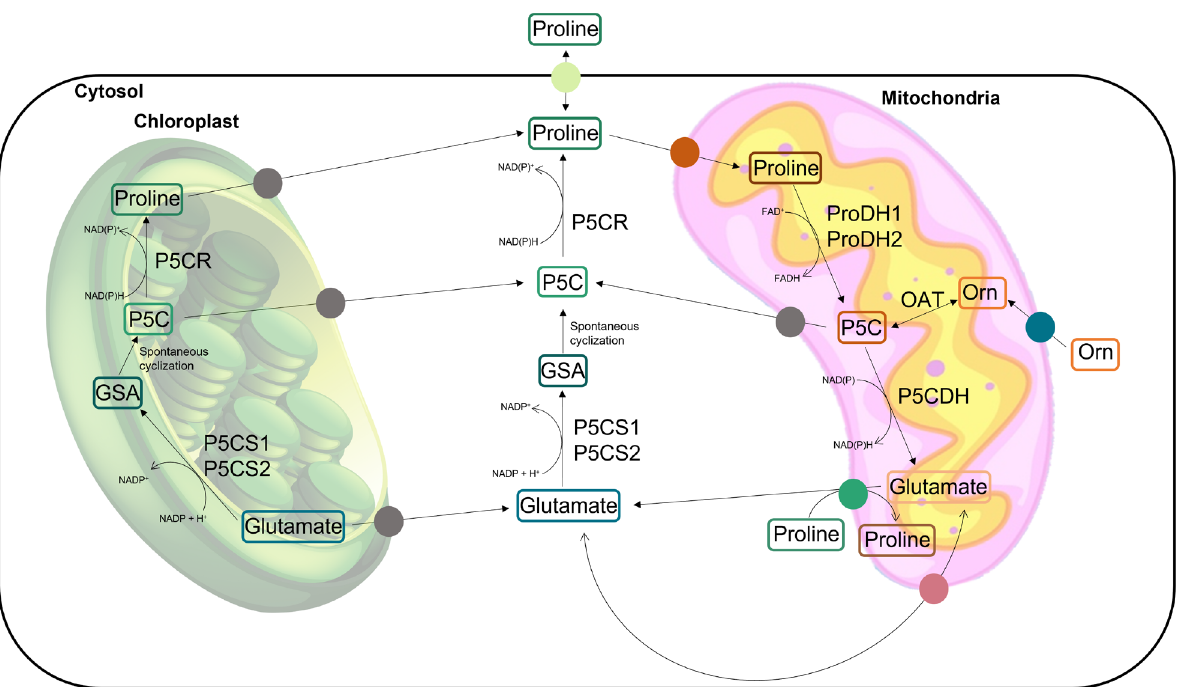
Figure 1. Overview of the main metabolic pathways responsible for proline biosynthesis in the cytoplasm and/or chloroplast and for proline catabolism in the mitochondria. The protein trans- porters involved are highlighted in colored circles. Putative transporters are presented as grey circles. P5CS: ∆ 1-pyrroline-5-carboxylate-synthetase; P5CR: ∆ 1-pyrroline-5-carboxylate-reductase; GSA: glutamic-5-semialdehyde; P5C: pyrroline-5-carboxylate; ProDH: proline dehydrogenase; P5CDH: pyrroline-5-carboxylate dehydrogenase; and OAT: ornithine δ -aminotransferase.